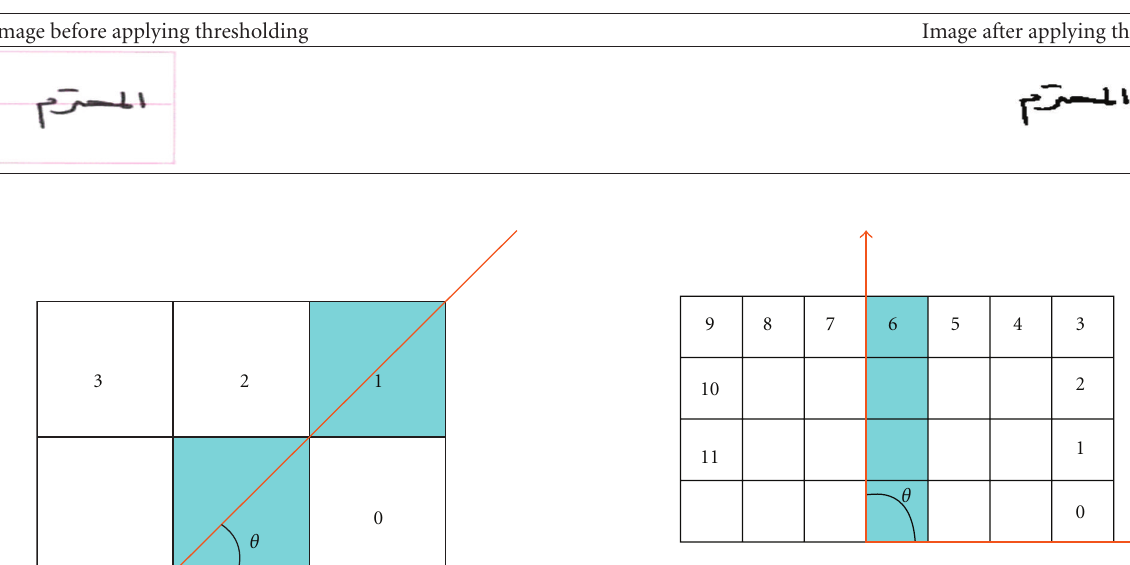
Figure 3: Extraction of the edge-direction distribution using four angles.